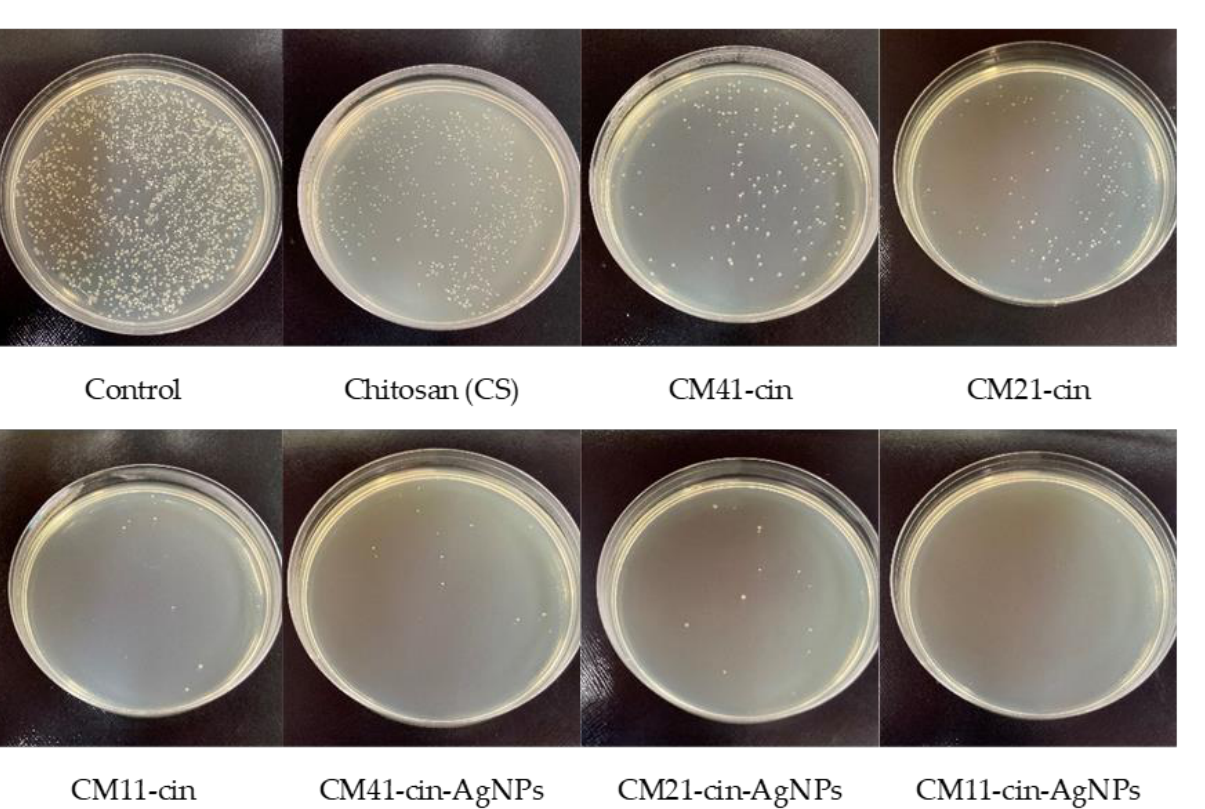
Figure 7. The representative agar plate image of viable E. coli counts after 6 h of contact with differ- ent hydrogels. Control